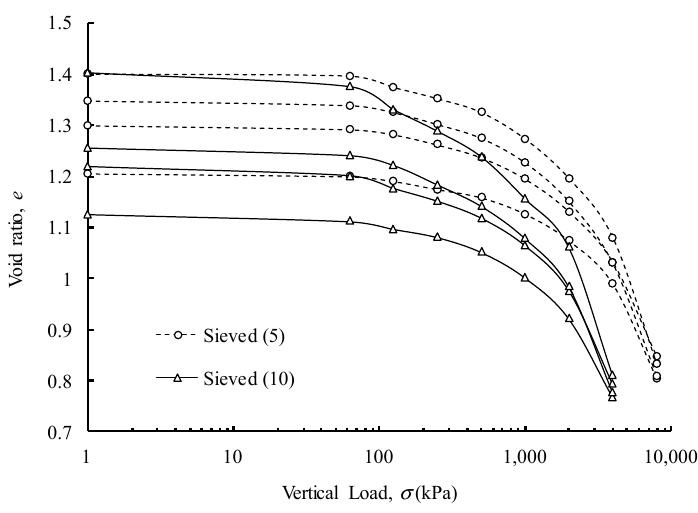
Figure 4. Comparison of the compression curves for mixtures with different rubber contents.